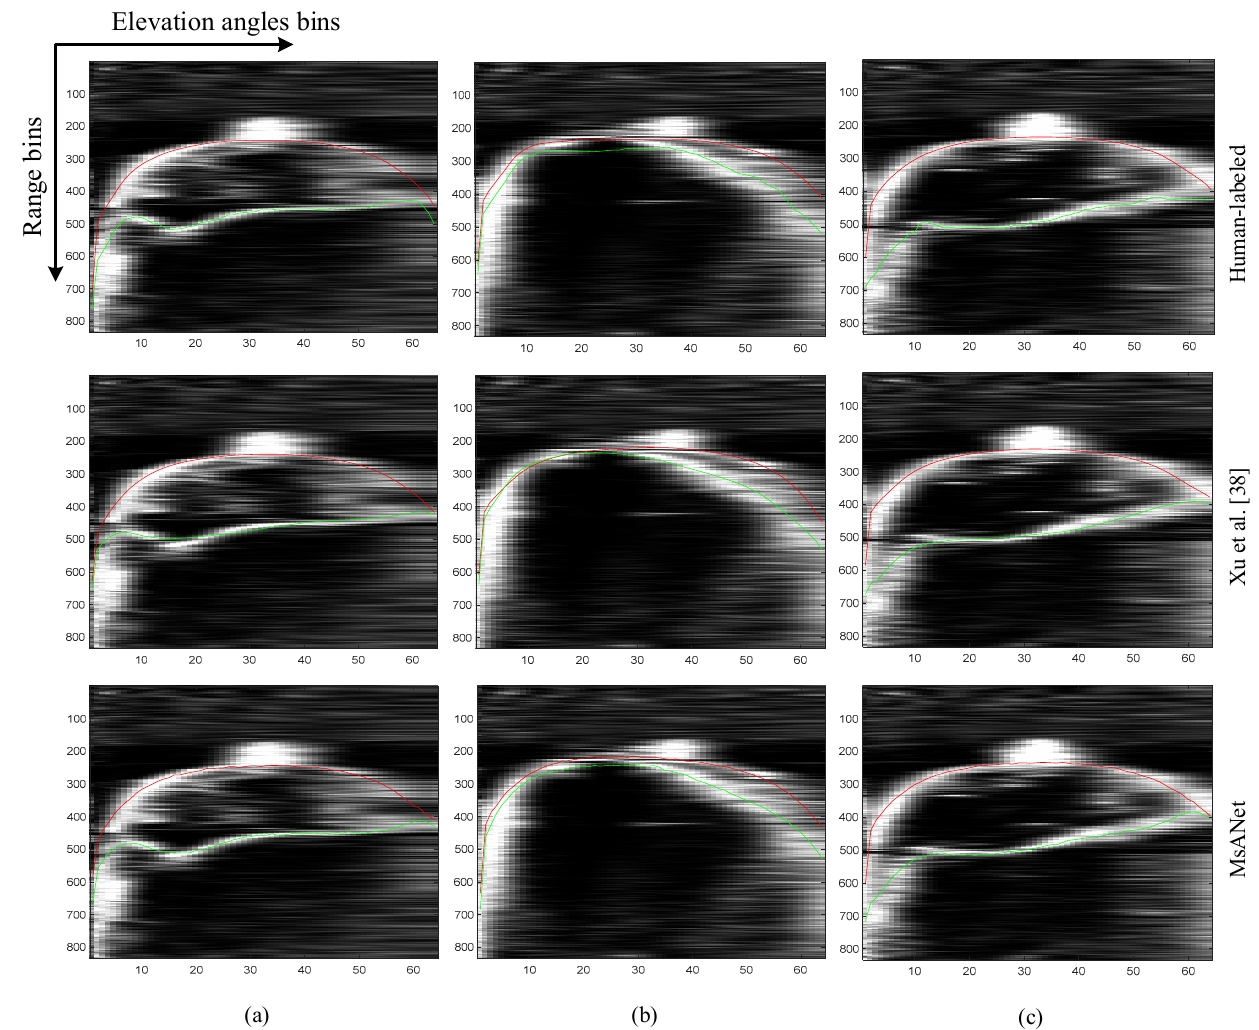
Figure 9. Visualization of radar topology slices. ( a – c ): Three set of comparison of extracted ice-surface layer positions and ice-bottom layer positions obtained by human labeled, method of Xu et al. [38], and method of MsANet. For better viewing, images are converted to gray-scale. The red line indicates the ice-surface layer and the green one is the ice-bottom layer. The width direction represents the elevation angle bins and the height direction represents the range bins, which is the same as the fast-time axis.